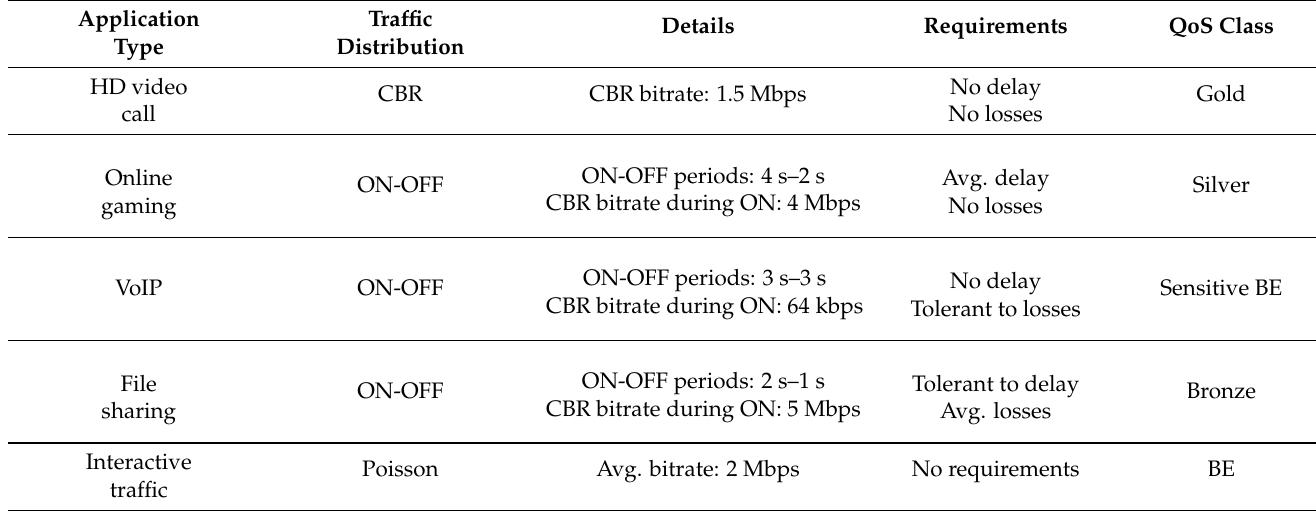
Table 4. Synthetic application traffic flow characteristics and QoS class